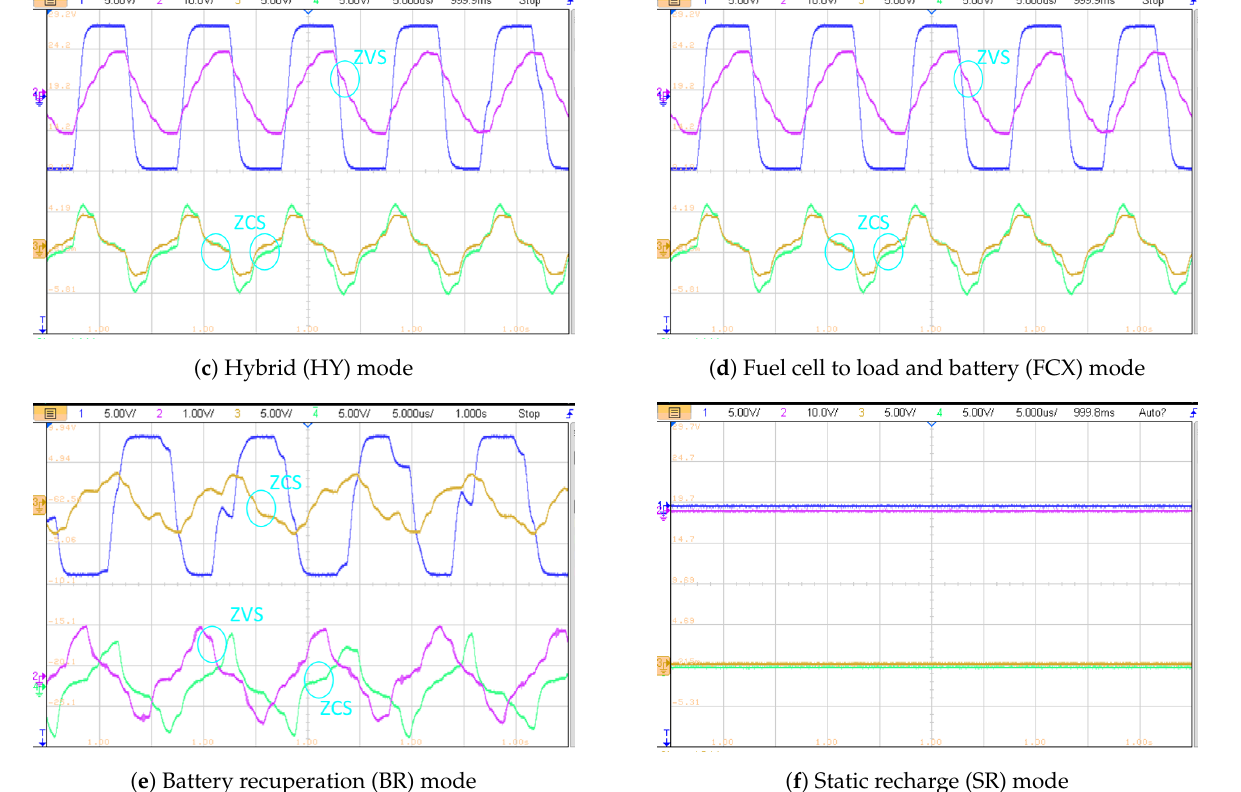
Figure 24. Experimental results of resonant stage waveforms (CH1 (blue): Primary switch node voltage, CH2 (red): Primary resonant tank current, CH3 (yellow): Secondary resonant tank current and, CH4 (green): Tertiary resonant (LLC secondary) current) for all six